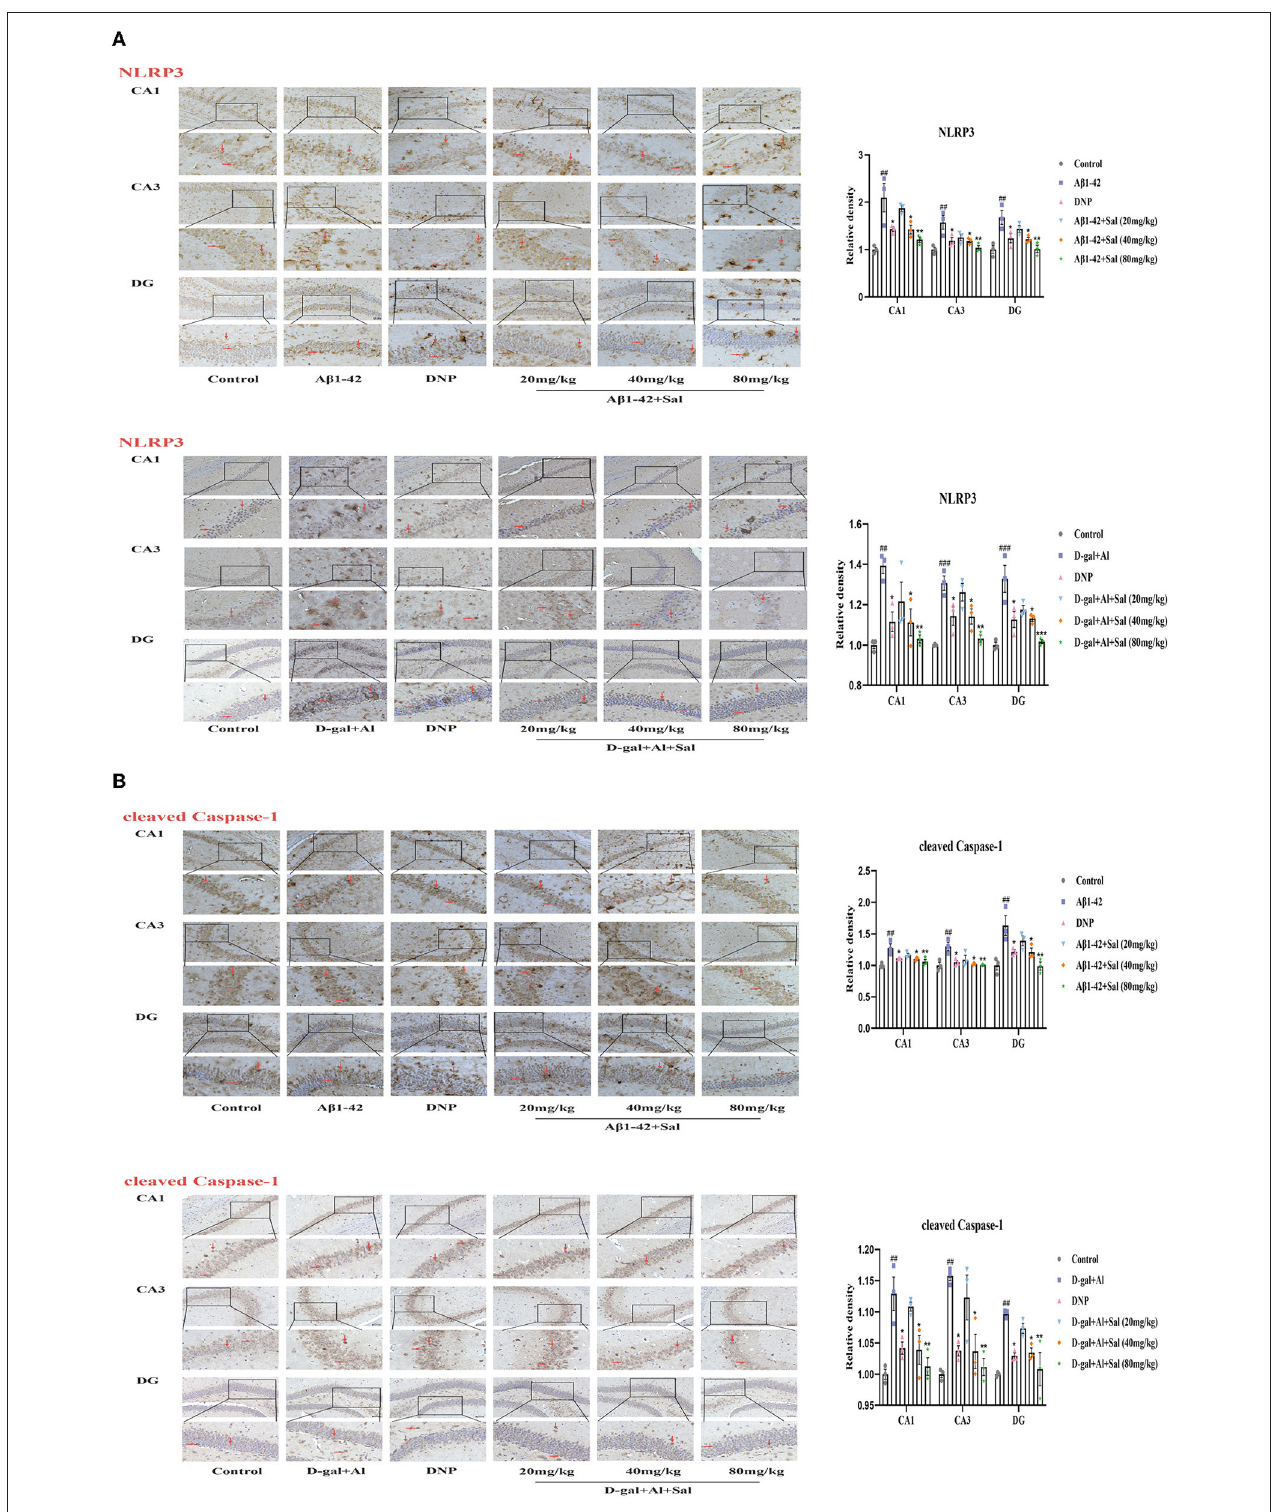
FIGURE 8 | Sal suppressed pyroptosis in A β 1-42 and D-gal/AlCl 3 -induced AD mice via NLRP3/Caspase-1 or TLR4/NF- κ B/NLRP3/Caspase-1 signaling pathway. Immunochemical staining of NLRP3 (A) , cleaved caspase-1 (B) in the CA1, CA3, and DG regions of the hippocampus of AD mice brains, and the IHC staining results are shown by arrows; scale bar = 50 µ m, Original magnification: x200. Quantitative analyses of the NLRP3, cleaved caspase-1 positive area in the hippocampus by Image J. Values are expressed as mean ± SEM ( n = 3). ## P < 0.01, ### P < 0.001, vs. control group, * P < 0.05, ** P < 0.01, *** P < 0.01 vs. A β 1-42 and D-gal/AlCl 3